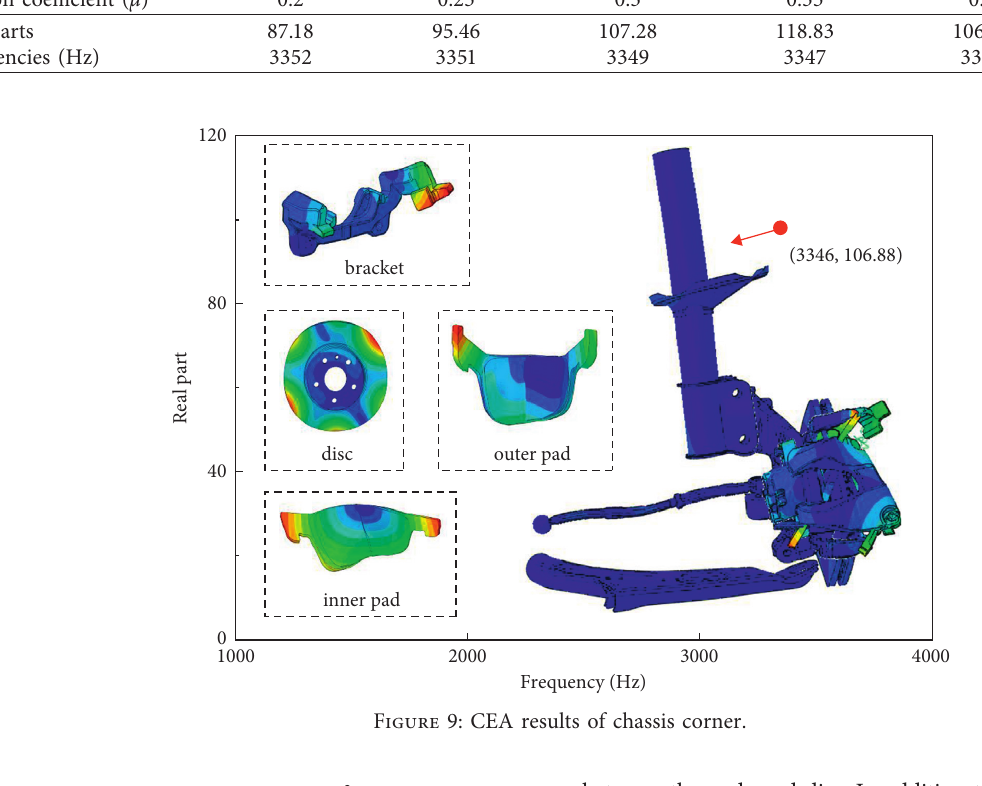
Figure 9: CEA results of chassis corner.